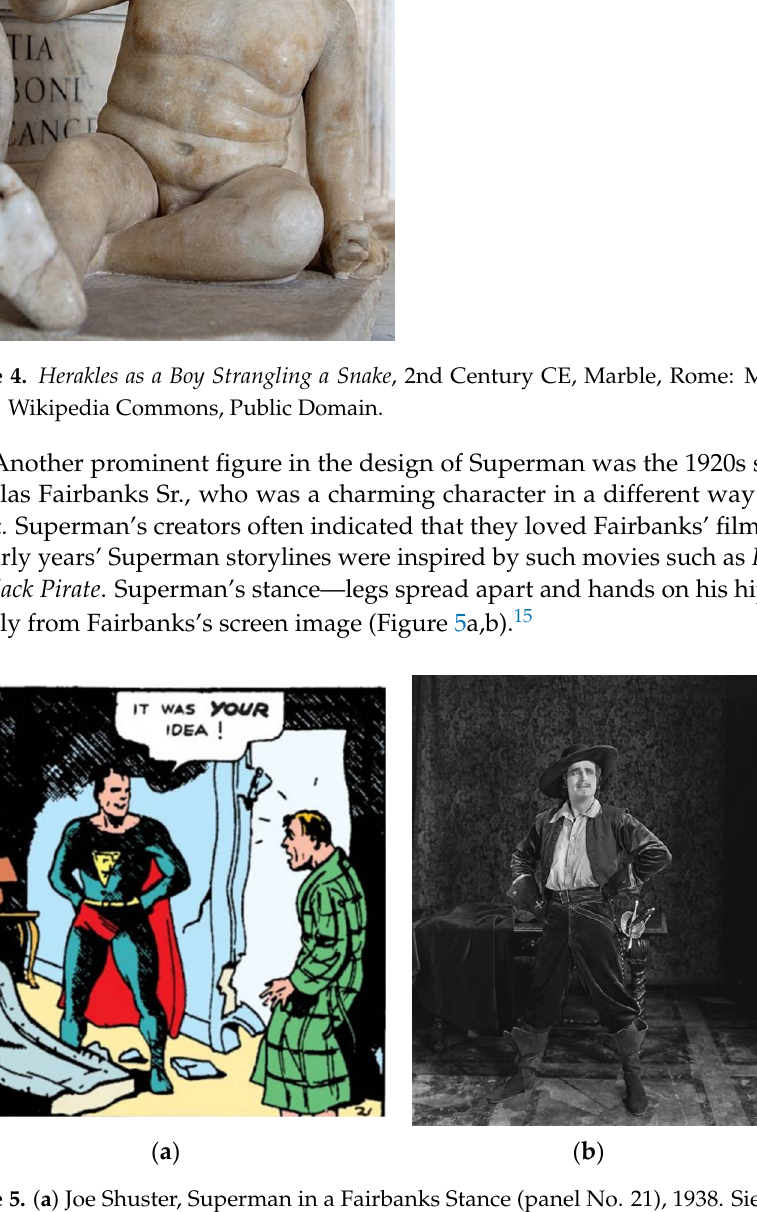
Figure 6. Joe Shuster, Superman, ink drawing, probably 1970s. © DC Comics. Along with the Hollywood influence, other media influenced the shaping of Super- man’s image. The most prevalent aspect in the research field is the “Strongman” figure Siegmund Brietbart and the bodybuilding magazines (Andrae and Gordon 2010, pp. 55– 61). It is well known that, owing to his shyness, from a young age Shuster started to build up his body to increase his self-confidence. He was often to be found in the school’s gym and continued to work on his fitness throughout his adult life, a fact that was noted, for